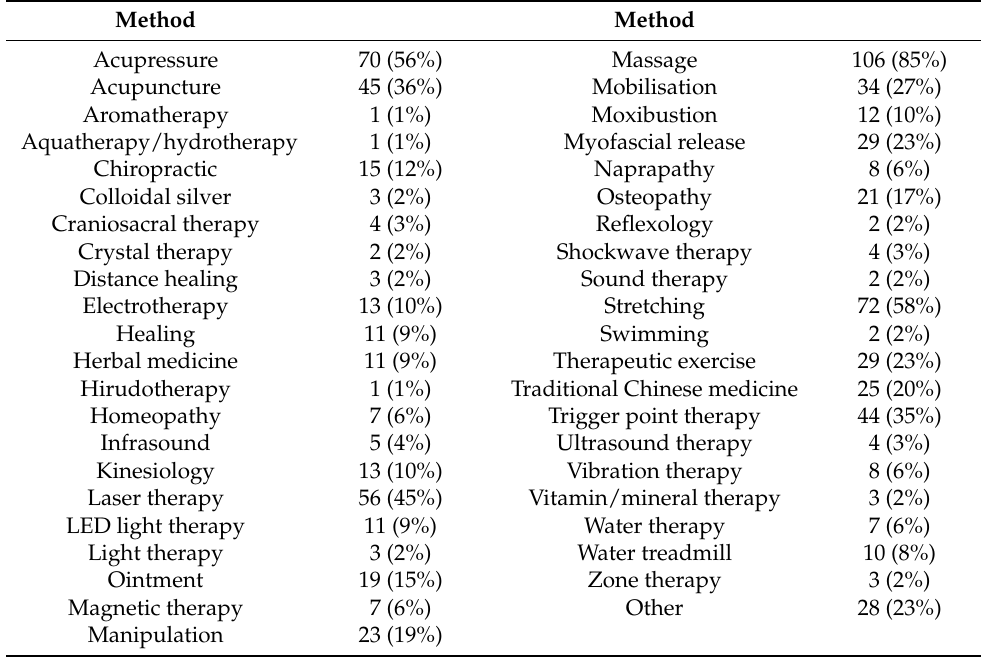
Table 4. Complementary and alternative veterinary medicine (CAVM) methods used on animals by Swedish therapists responding to a questionnaire ( n = 116, multiple choices possible).